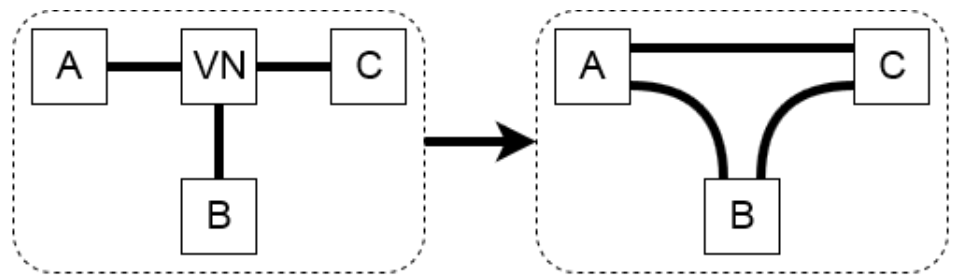
Figure 4. Remapping the connections to discard isomorphous topologies due to virtual nodes (VNs).